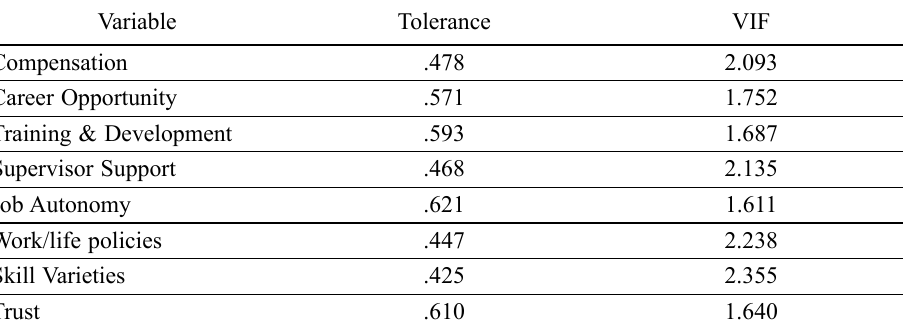
Table 2. Test of